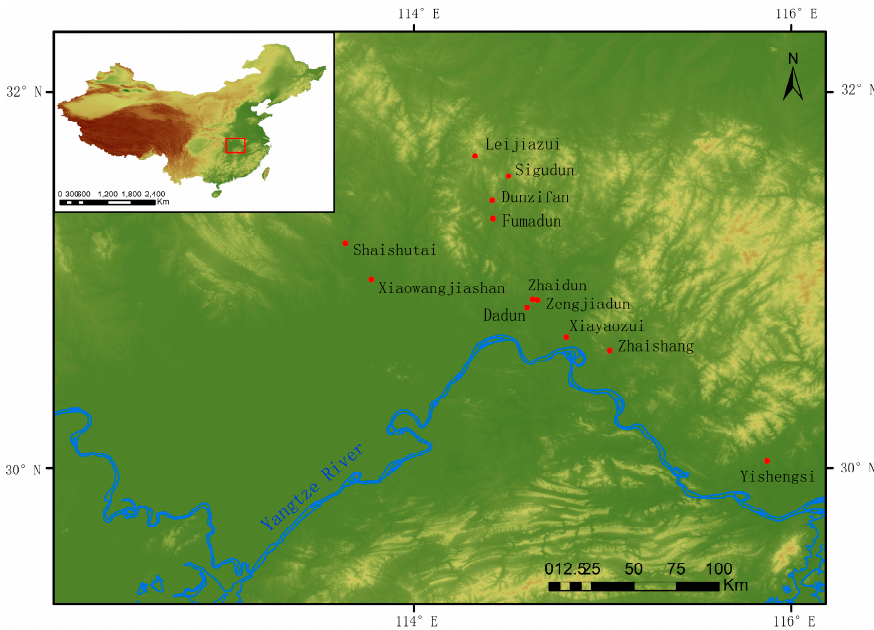
Figure 1. Distribution map of bronze age sites in this survey.